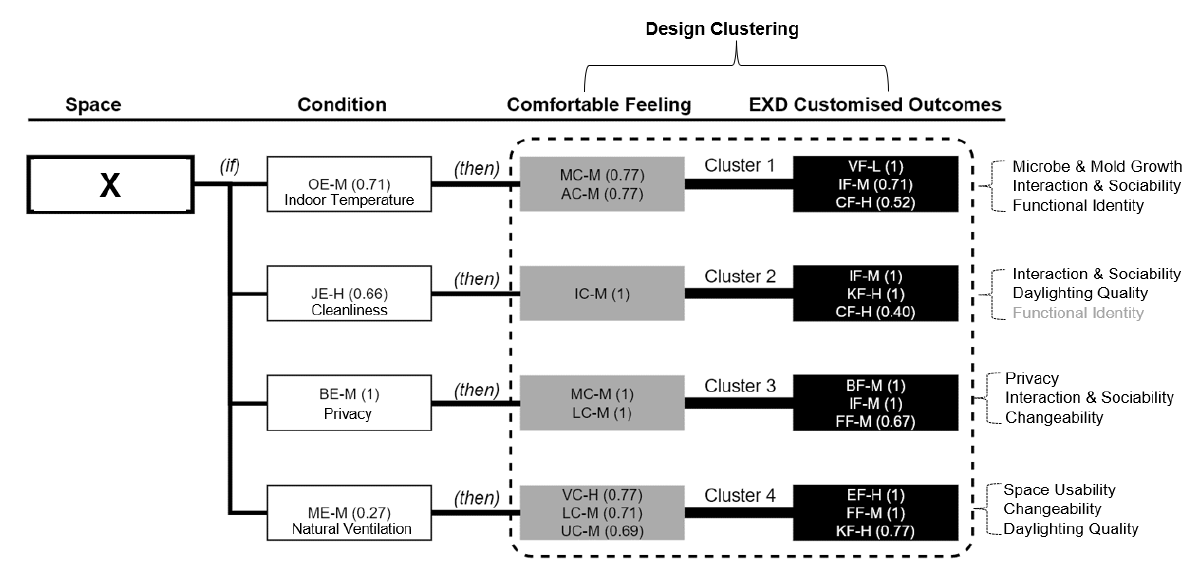
Figure 13. EXD customized outcomes for X as a domestic space. (Here: X = Master bed/childbed/toilet/kitchen/dining space/drawing space/corridor/balcony in a domestic area or others). (Source: author).